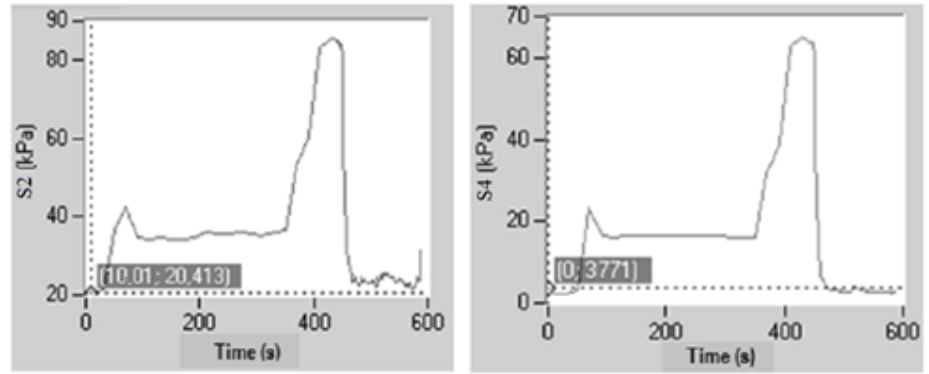
Figure 6. Pressure evolution in boreholes S2 and S4 after the employ of the PYROC system.